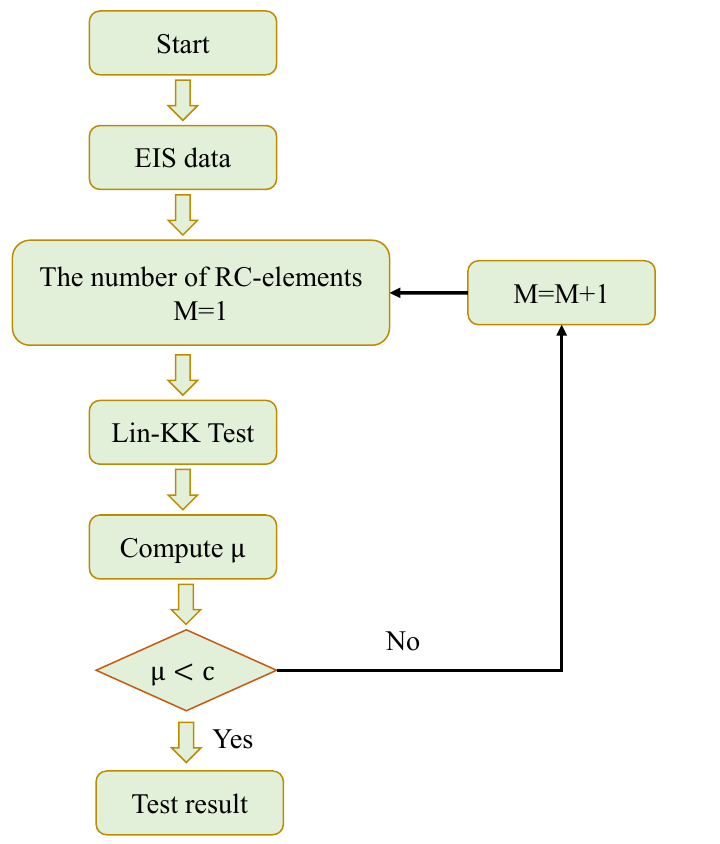
Figure 3. Lin—KK test flow chart. The value of is a design parameter, however from the previous study’s experience = 0.85 has proven to be an excellent choice. Using the Lin-KK method, the EIS data of six LIBs (25C01, 25C02, 35C01, 35C02, 45C01, 45C02) at different temperatures and SOC until the end-of-life cycle were tested. The fitting residual results are shown in Figure 4.